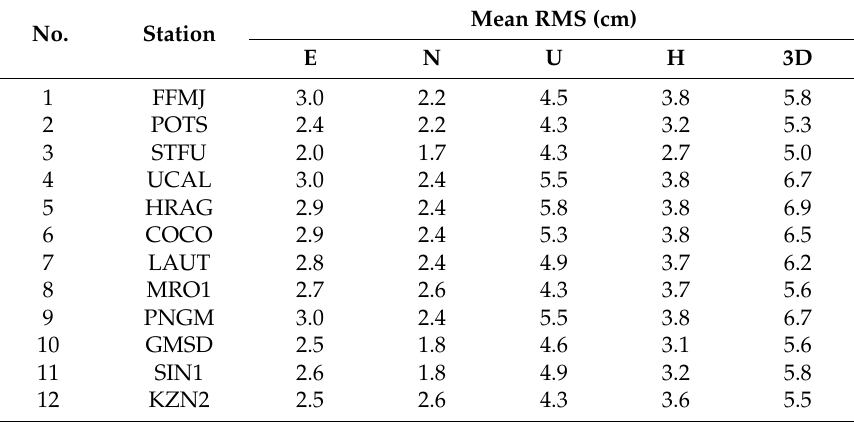
Figure 9. The daily root mean square (RMS) values of positioning errors for each station. Table 5. Mean RMS value of positioning errors for each station.